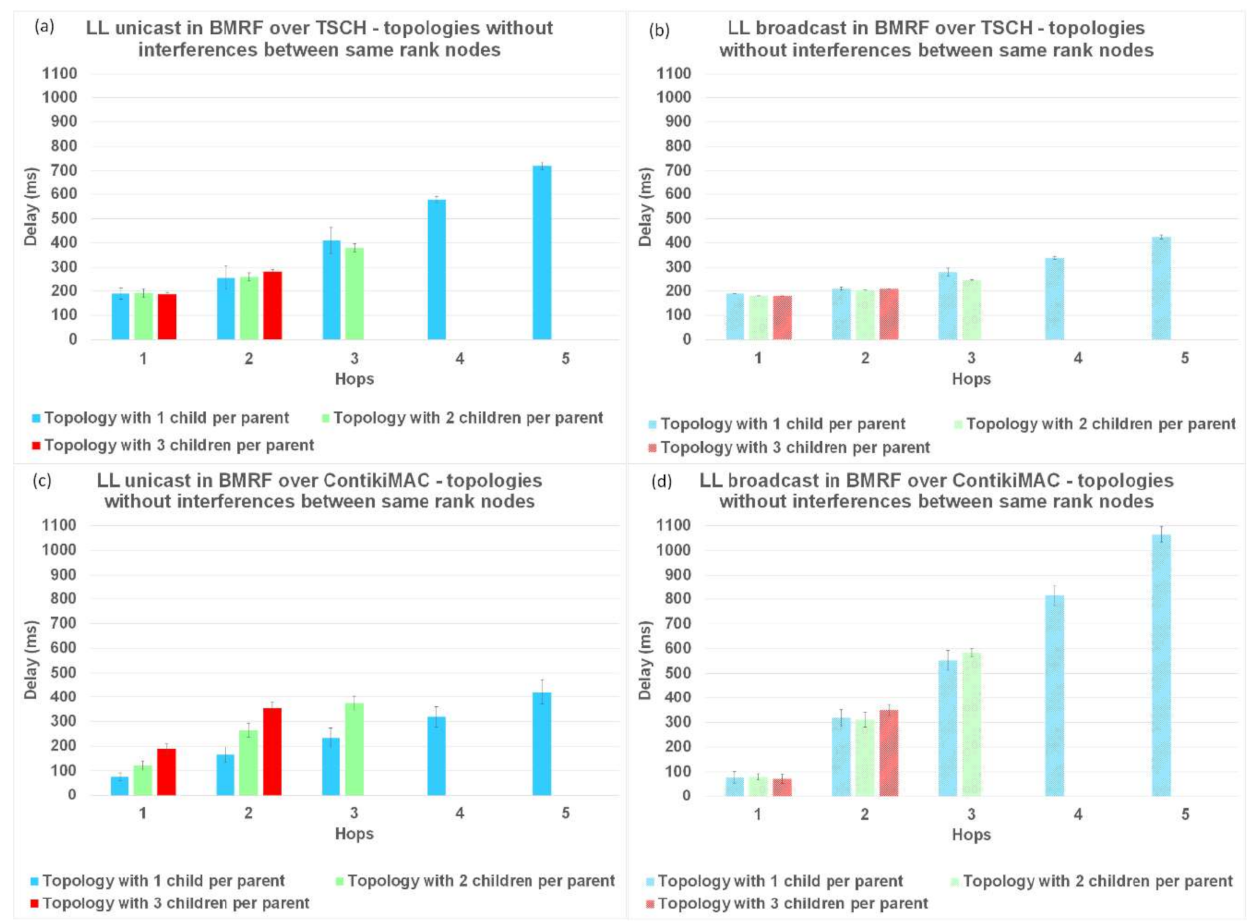
Figure 11. Delay comparison between LL unicast and LL broadcast and between ContikiMAC and TSCH on topologies without interference between same rank nodes. ( a ) Results for LL unicast in BMRF over TSCH. ( b ) Results for LL broadcast in BMRF over TSCH. ( c ) Results for LL unicast in BMRF over ContikiMAC. ( d ) Results for LL broadcast in BMRF over